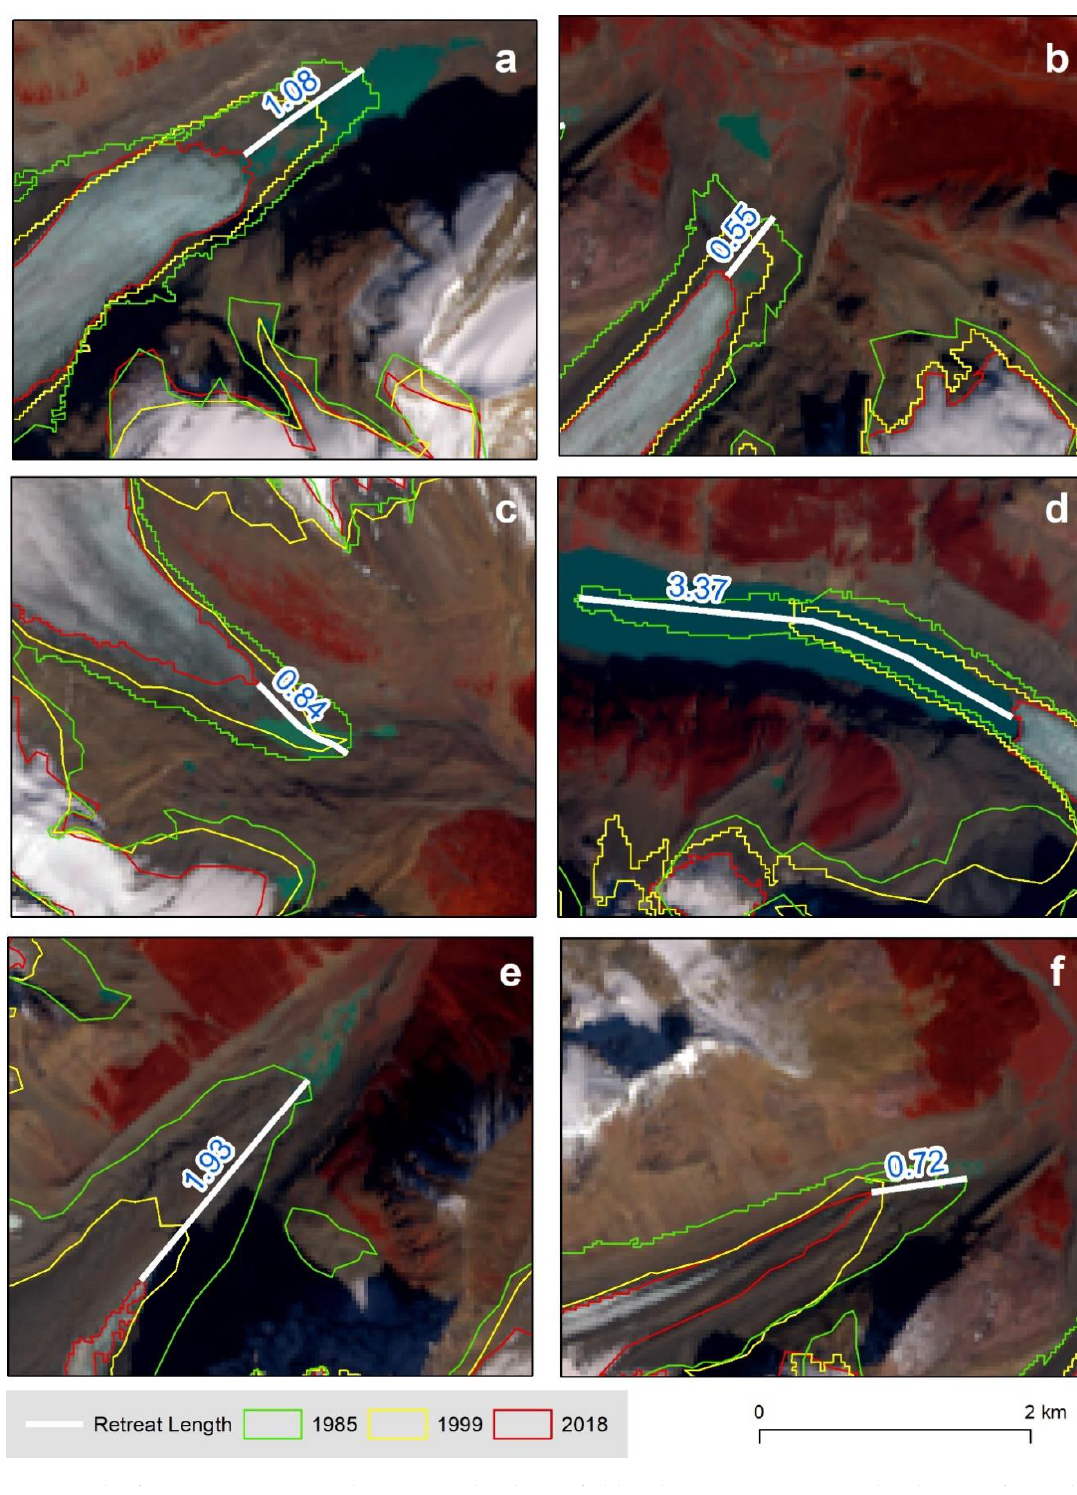
Figure 2. Length of retreat in six major glaciers in Columbia Icefield. *Glacier names: ( a ) = Saskatchewan, ( b ) = Athabasca, ( c ) = Castleguard, ( d ) = Columbia, ( e ) = Stutfield, ( f ) = Dome.